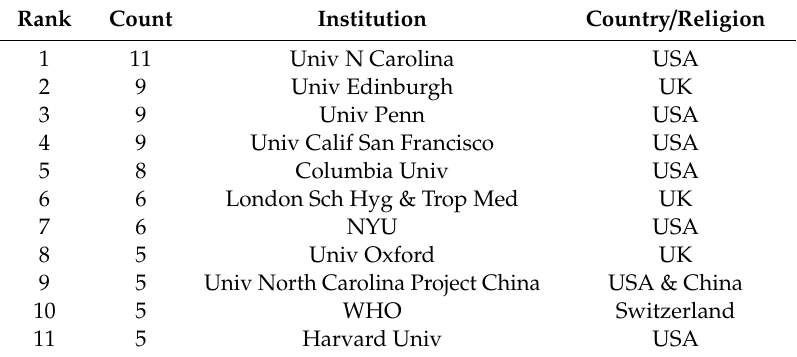
Table 2. Top 11 productive institutions of crowdsourcing research in public health.